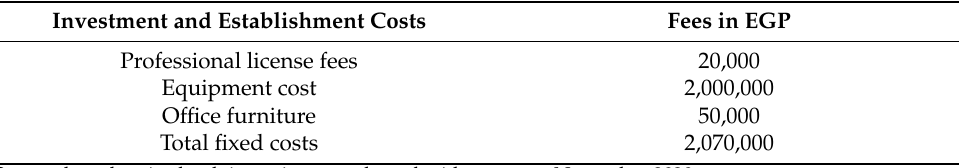
Table 4. Investment costs.